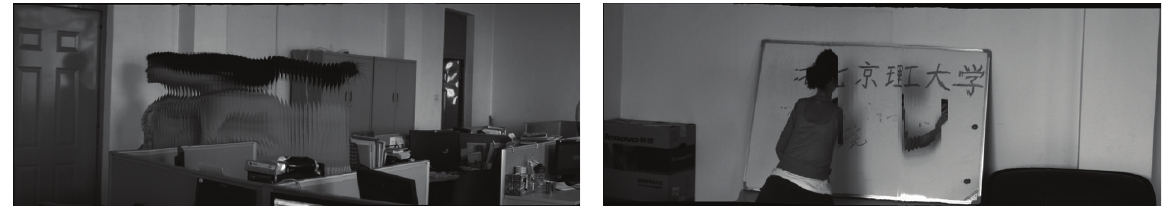
Figure 7: Stitching results of [6].